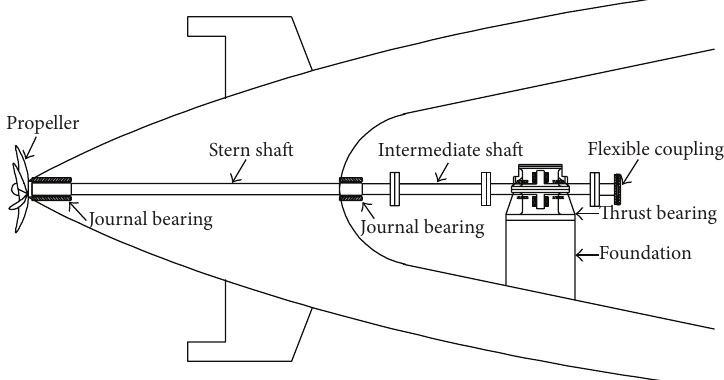
Figure 1: Schematic diagram of submarine propulsion shafting